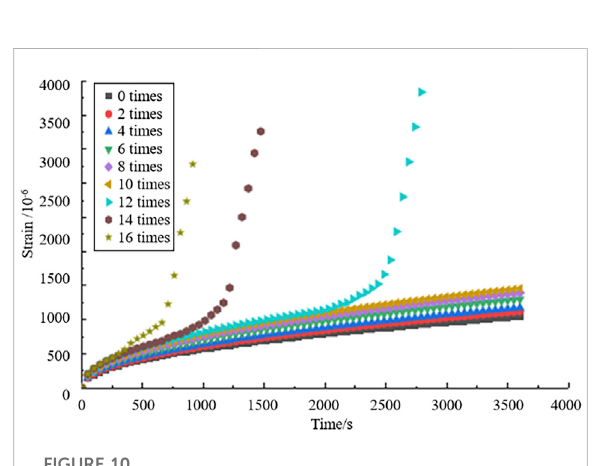
FIGURE 10 Freeze-thaw creep curves of composite modi fi ed OGFC at mixing ratios of